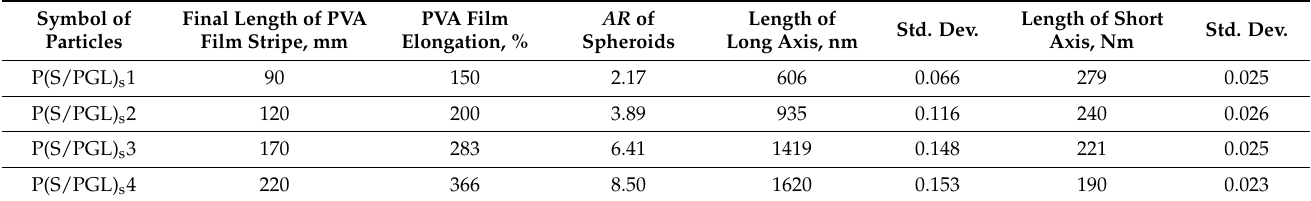
Table 1. Basic characteristics of spheroidal particles and elongation